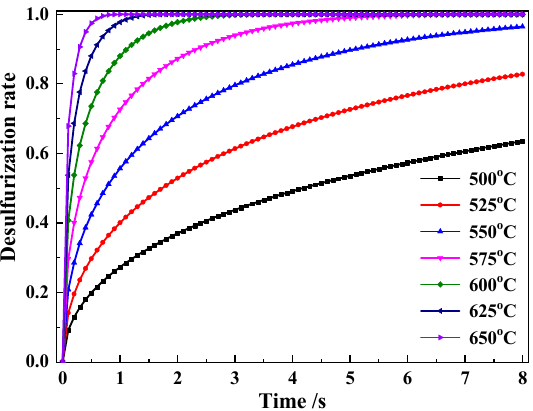
Figure 8. Desulfurization reaction curves predicted using the kinetic equation.